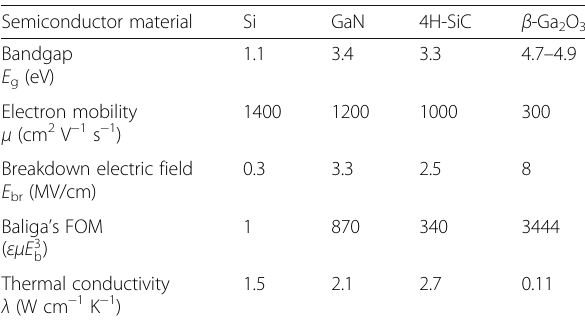
Table 1 Comparison of the physical properties of Si, GaN, SiC, and β -Ga 2 O 3 semiconductor [5]